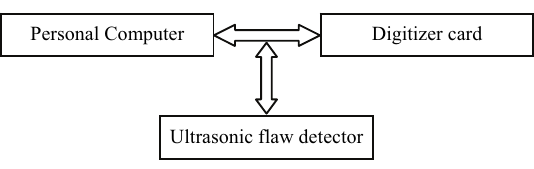
Fig. 2. The ultrasonic inspection